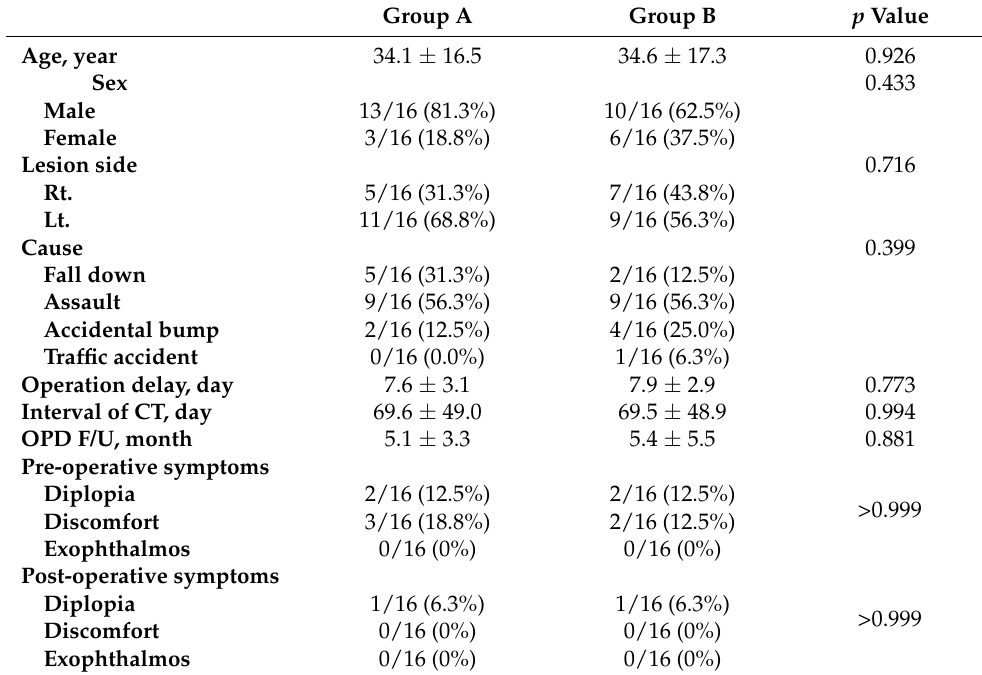
Table 1. The baseline characteristics and demographic data of the patients. Group A Group B